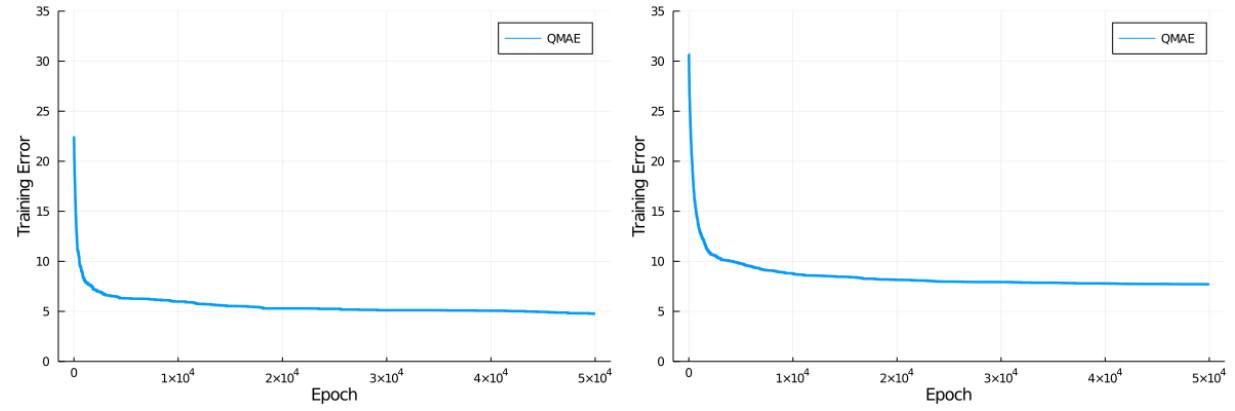
Figure 11. Unscaled QMAE training